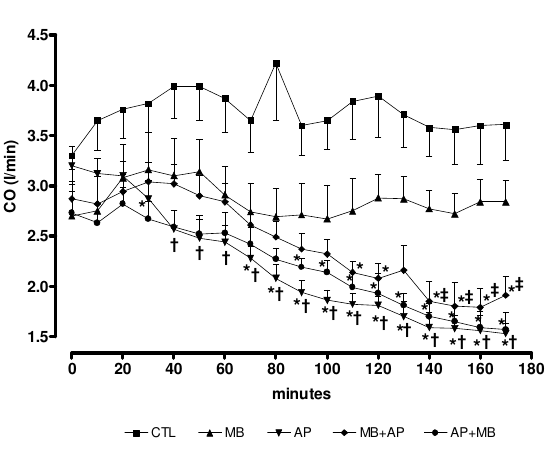
FIGURE 1 - Cardiac output (CO) results in all groups. In AP group CO decreased 52% (p<0.05) over time. In MB+AP group, there was 70 minutes delay (p<0.05) to decrease CO compared to AP group. MB after AP induction did not improve (p<0.05) CO. CTL (control group), MB (methylene blue group), AP (acute pancreatitis group), MB (methylene blue group), MB+AP (methylene blue plus acute pancreatitis group), AP+ MB (acute pancreatitis plus methylene blue